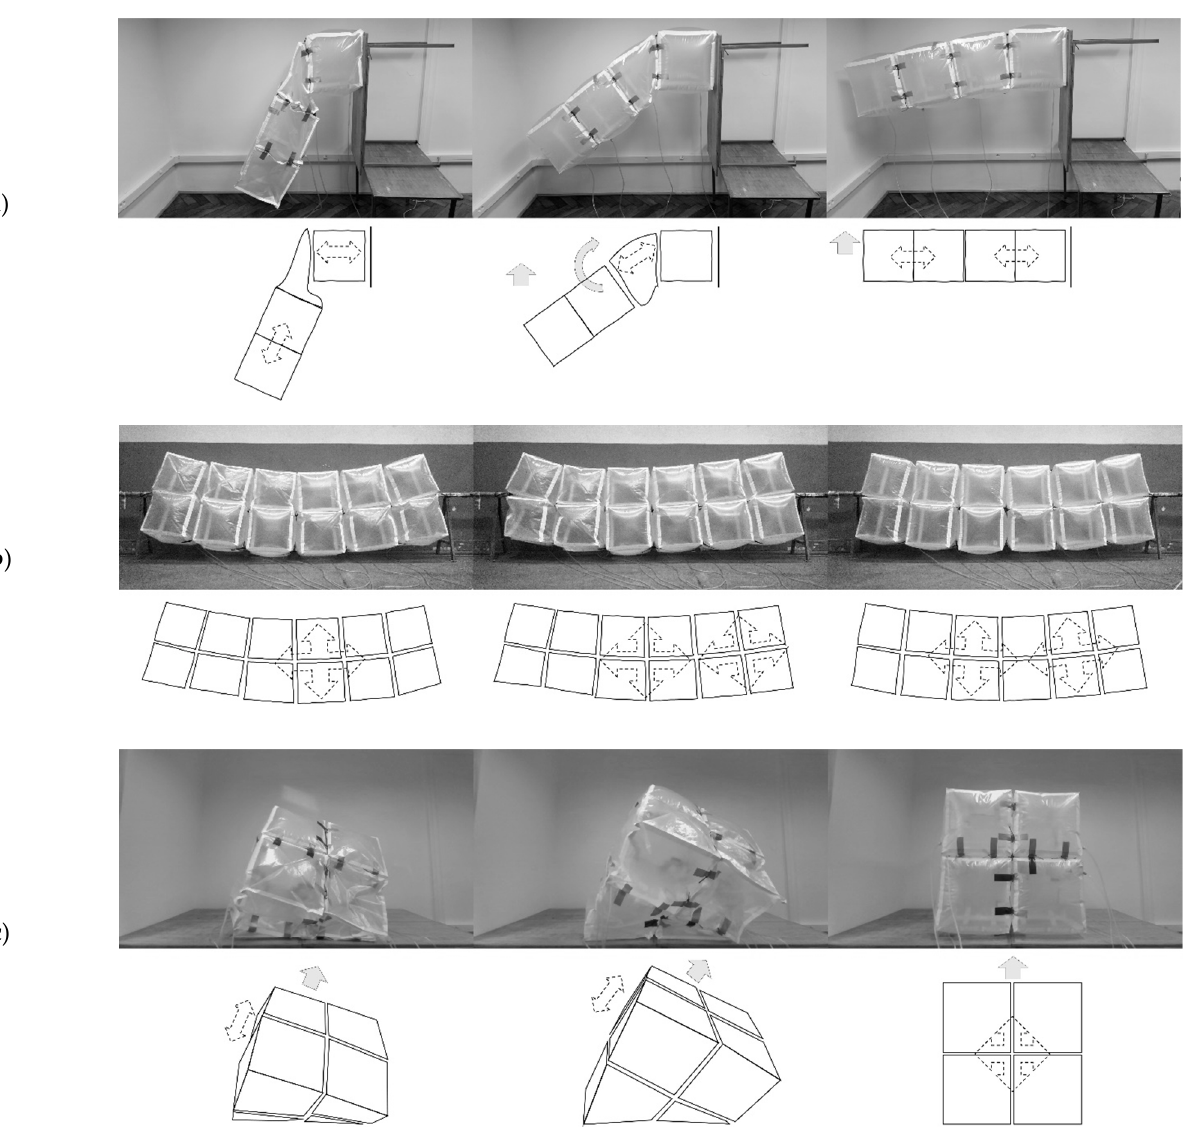
Figure 5. Testing done on the basic body plan type B; from top to bottom: ( a ) Type B1; ( b ) Type B2; ( c ) Type B3. Note: black and grey tape (which had silvery effect) were both used to connect the cubes which is why they may be differently visible.